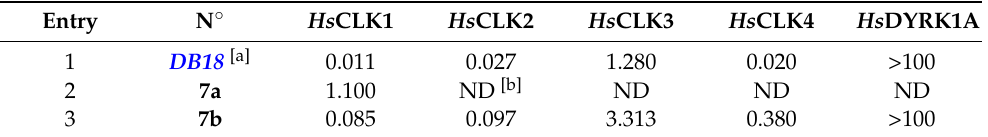
Table 1. IC 50 data ( µ M) for the inhibition of human kinases CLK1-4 and DYRK1A by the quinazolines DB18 and 7a and 7b . Each concentration of compound was tested in duplicate.